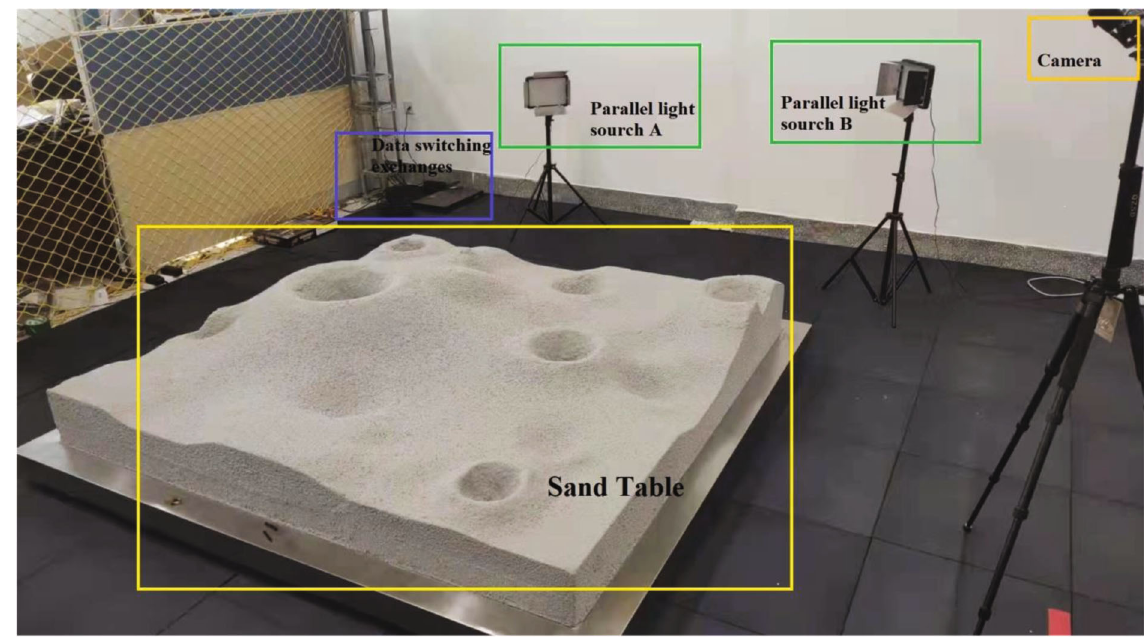
Figure 9: Hardware-in-loop simulation